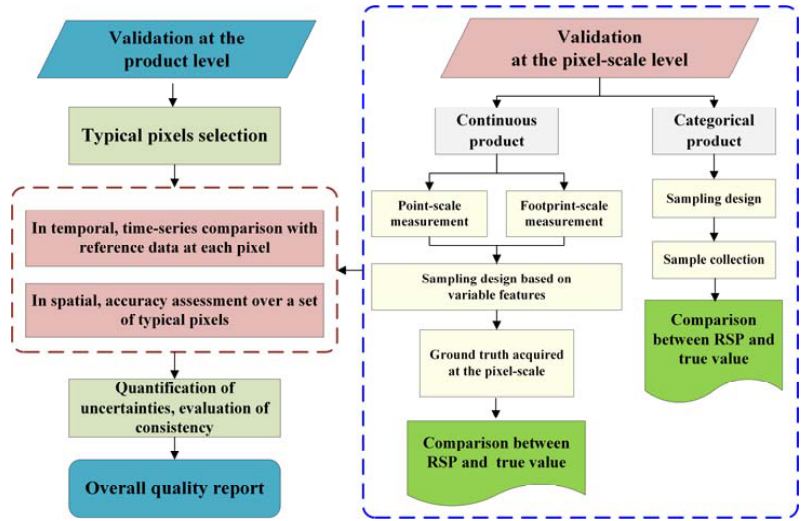
Figure 2. Sketch map of the two levels of validation considered in the validation guidelines [161].